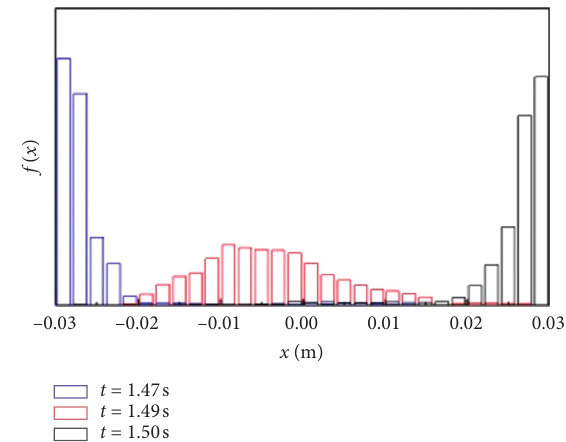
Figure 3: Distributions f ( x ) of the x coordinates of powder particles. Data refer to three different times during a simulation run investigating the ball and powder particle dynamics inside a reactor swung at 14.6Hz. The bin size is equal to